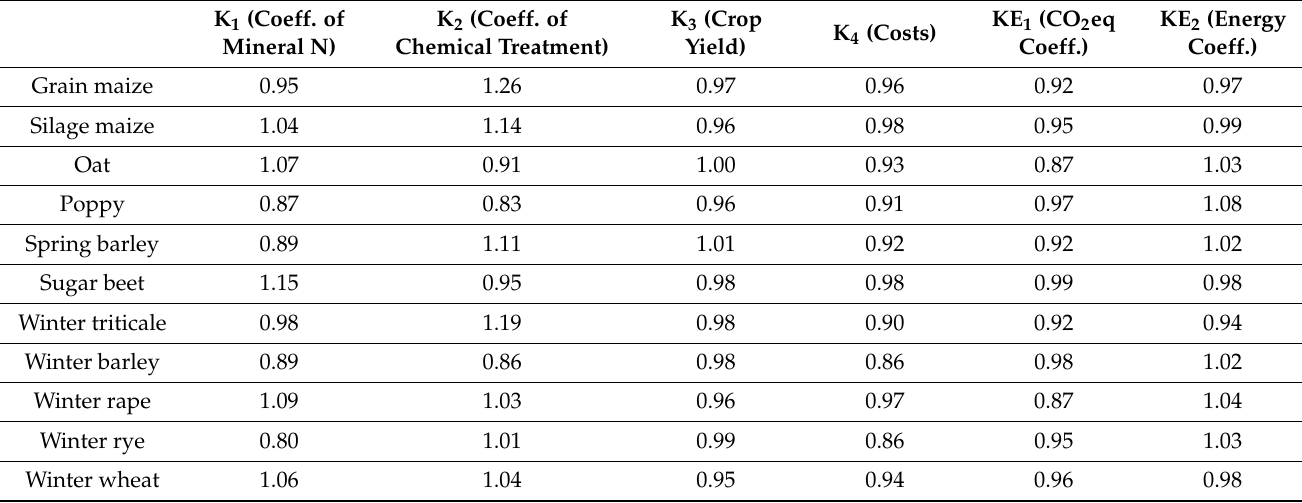
Table A14. Coefficients’ value of economic and environmental